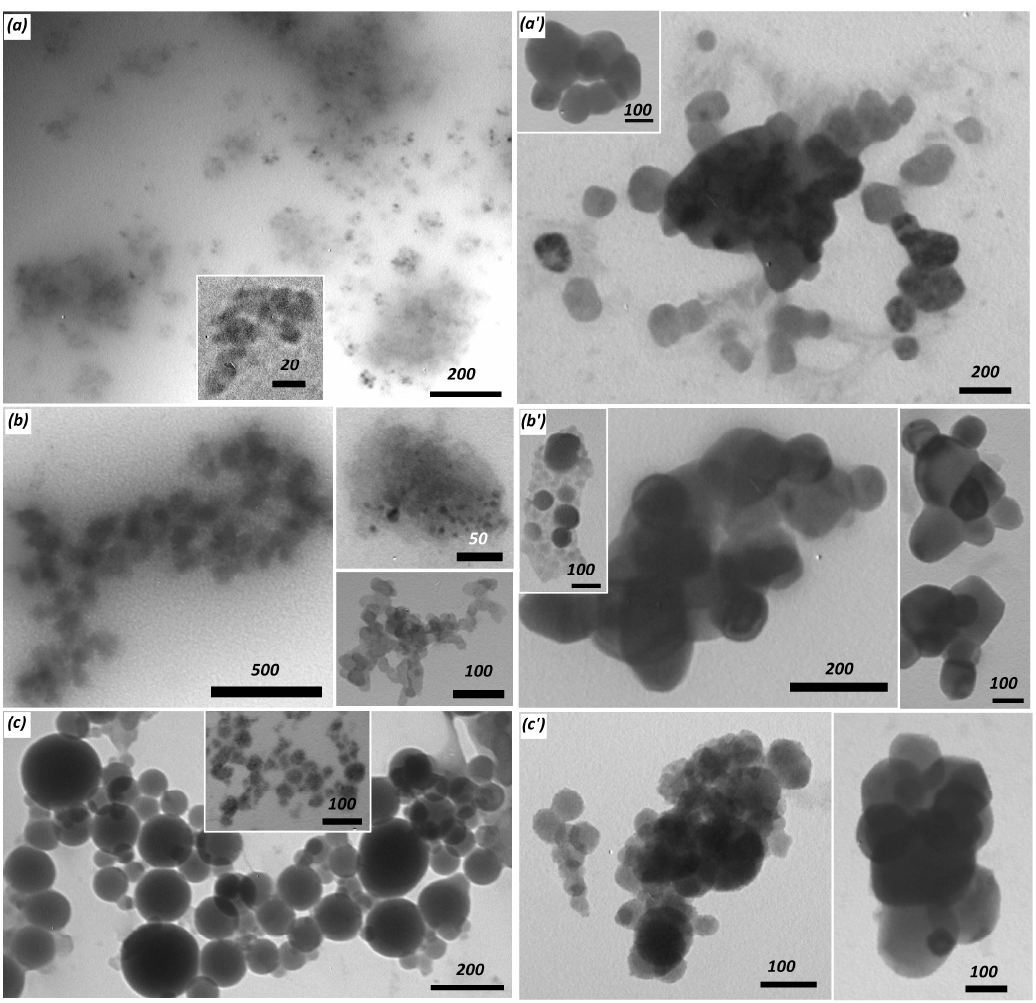
Figure 10. Transmission electron microscopy (TEM) images of composite particles obtained under silicic acid condensation in the presence of new polymers. ( a ) P01; ( b ) P11; and ( c ) P22 polymers. ( a’ , b’ , c’ ) complexes of the respective composite particles and DNA oligonucleotide. Initial Si(OH) 4 concentration is 7.5 mM, polymers = 0.4 g · L − 1 , and composite = 10 μ M DNA ratio is 4:1 (volume to volume). Scale bars are presented in nm.